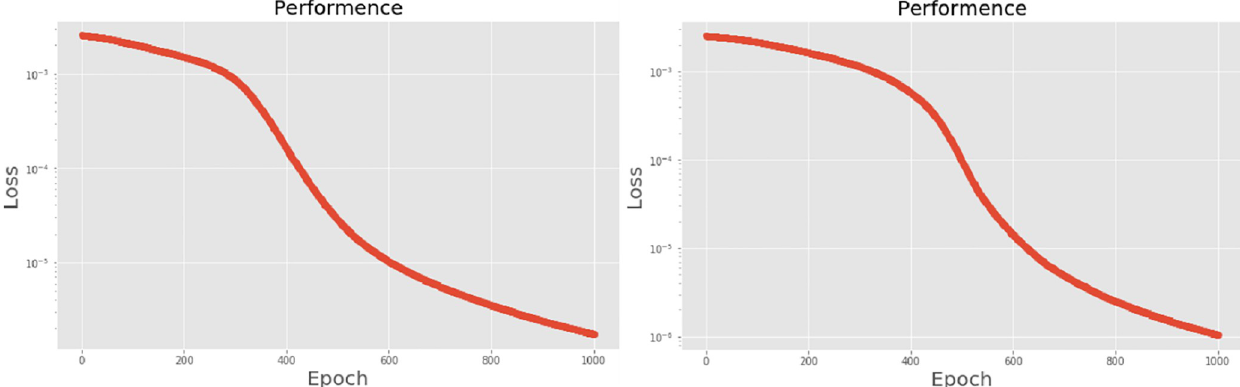
Fig 18. (a) The graph shows the performance of MFCC-DNN-16-layer model; (b) The graph shows the performance of MFCC-PCA-DNN-16-layer